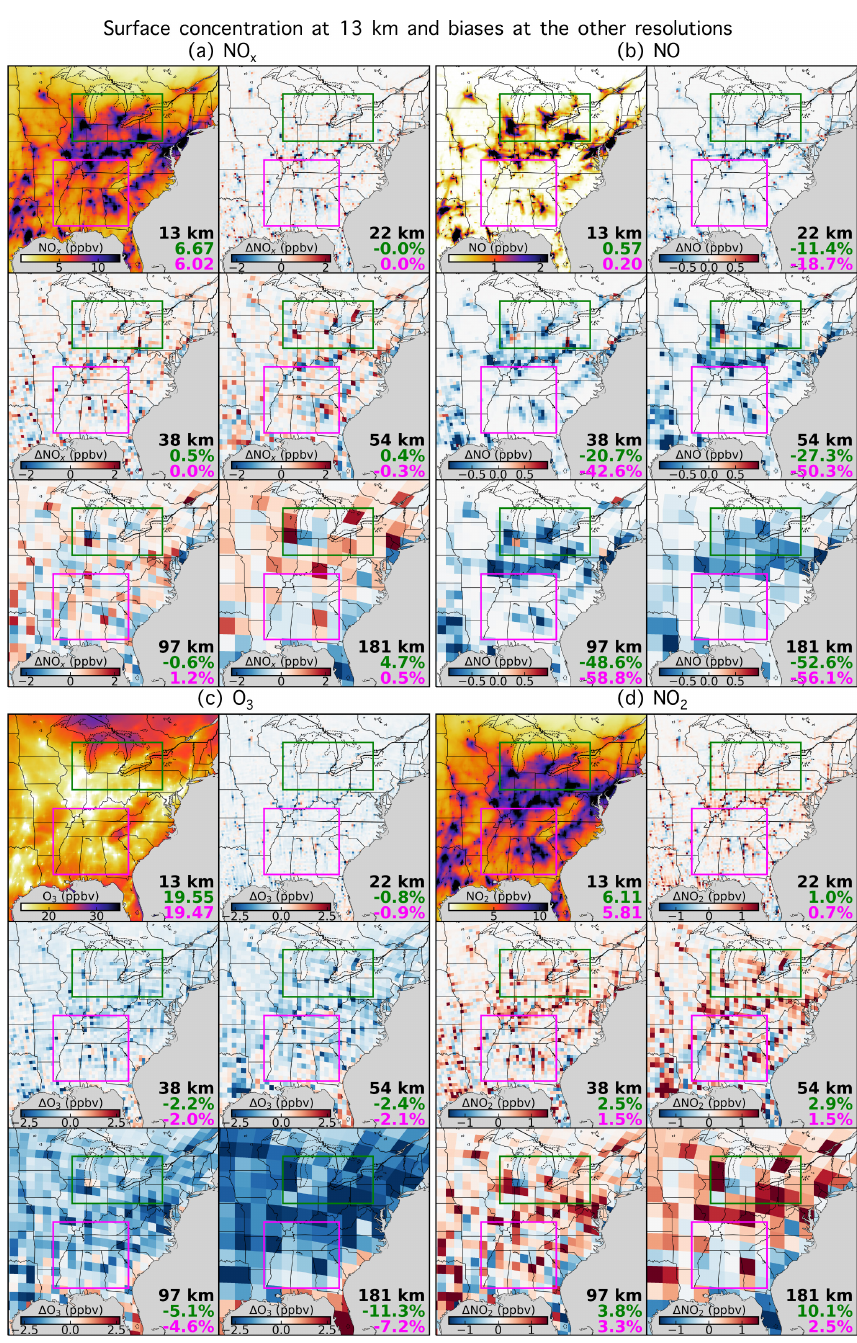
Figure 2. Nighttime (03:00–10:00UTC or 21:00–04:00CST) resolution effects of surface NO x concentration driven by NO titration of O 3 (e.g., Fig. A4) during January 2015. Each panel is similar to Fig. 1c but for nighttime surface mixing ratios of (a) NO x , (b) NO, (c) O 3 and (d) NO 2